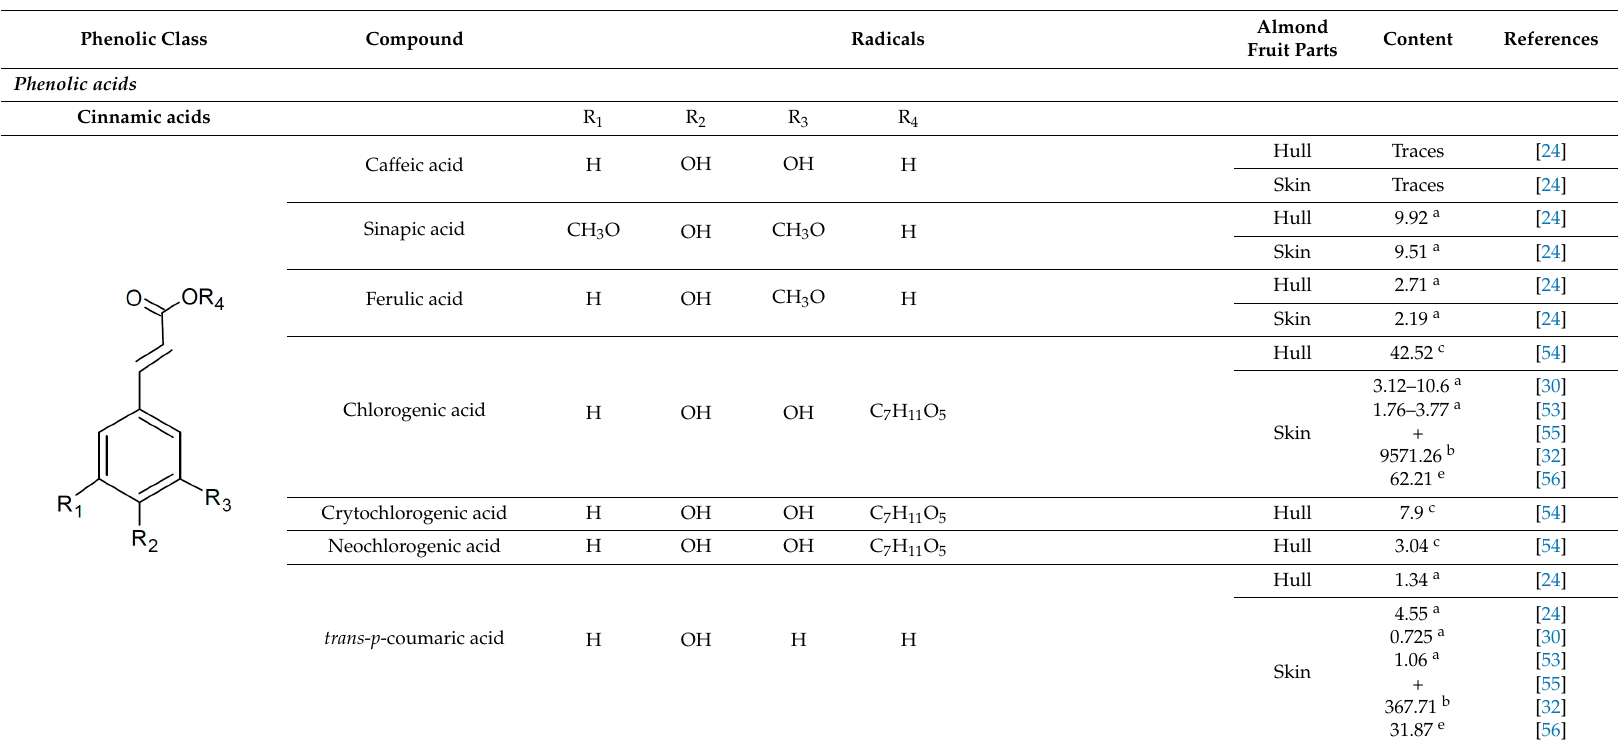
Table 1. Phenolic compounds present in almond by-products.